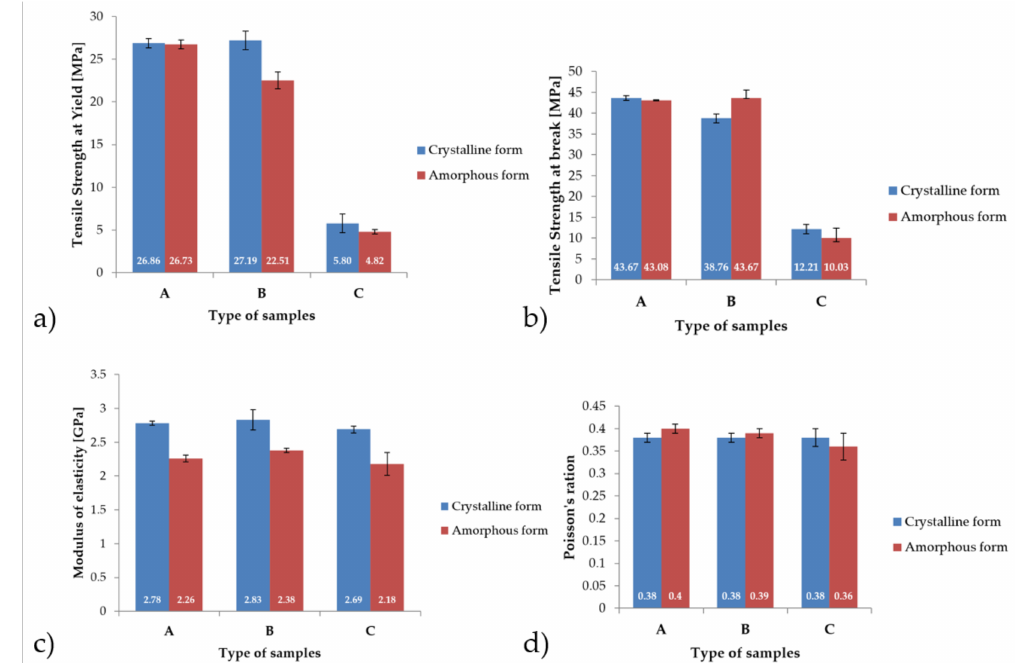
Figure 5. Comparison of the mechanical properties obtained during the uniaxial tensile experiments of samples type A, B and C: ( a ) Strength at Yield, ( b ) Strength at break, ( c ) Modulus of elasticity, ( d ) Poisson’s ratio.